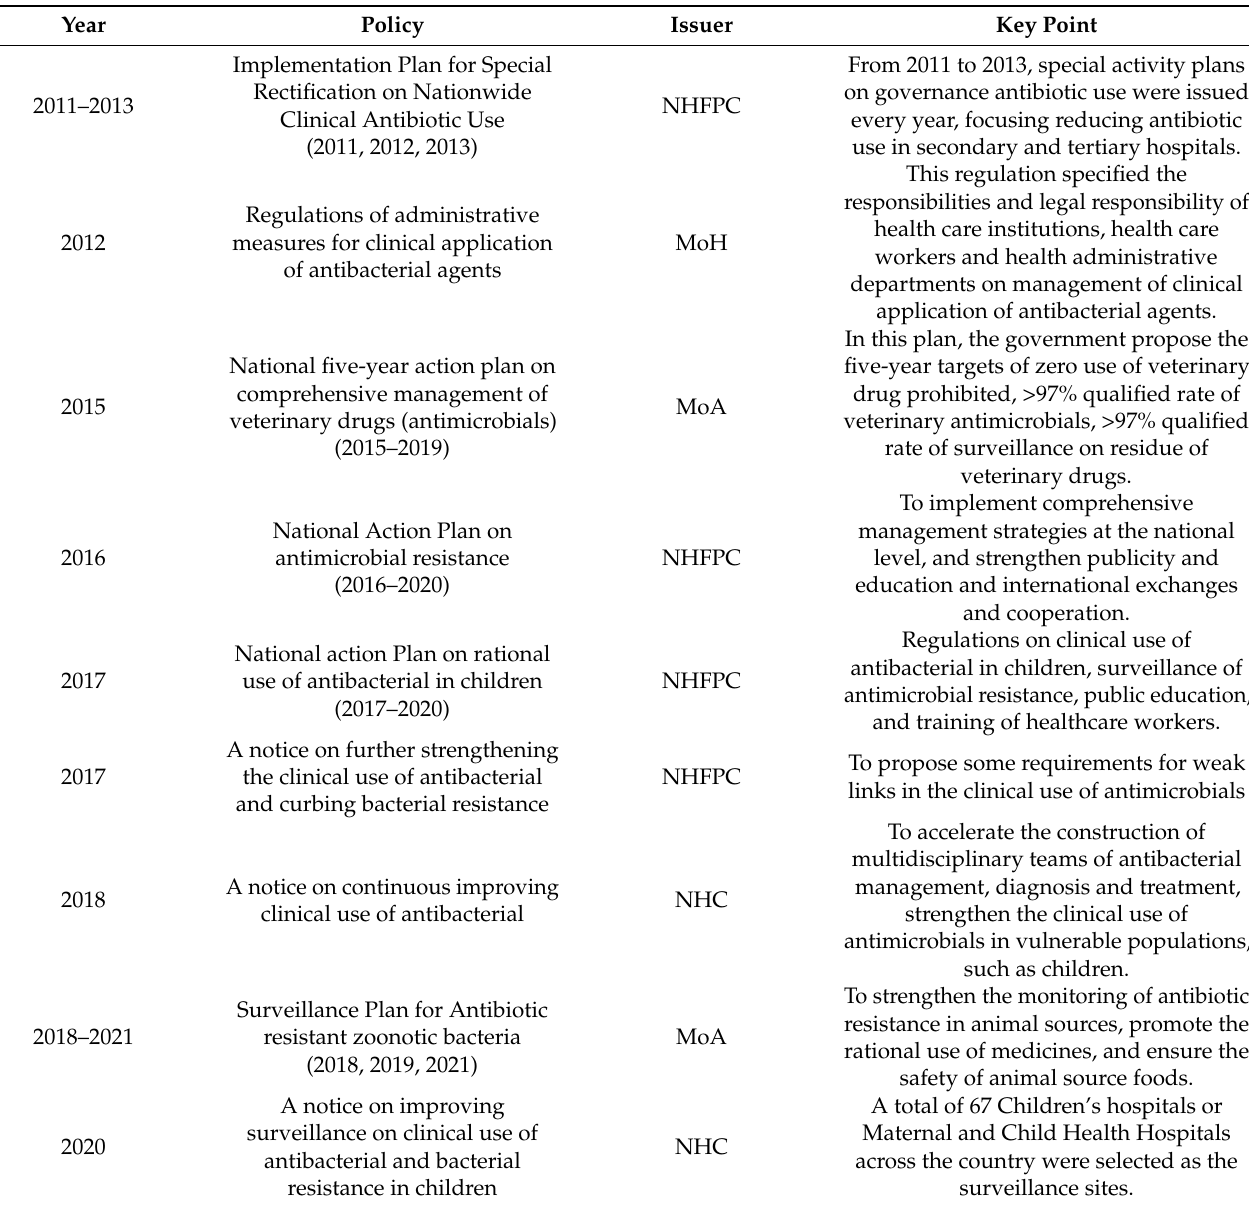
Table 3. Policy and regulation milestones on AMR control in China at stage